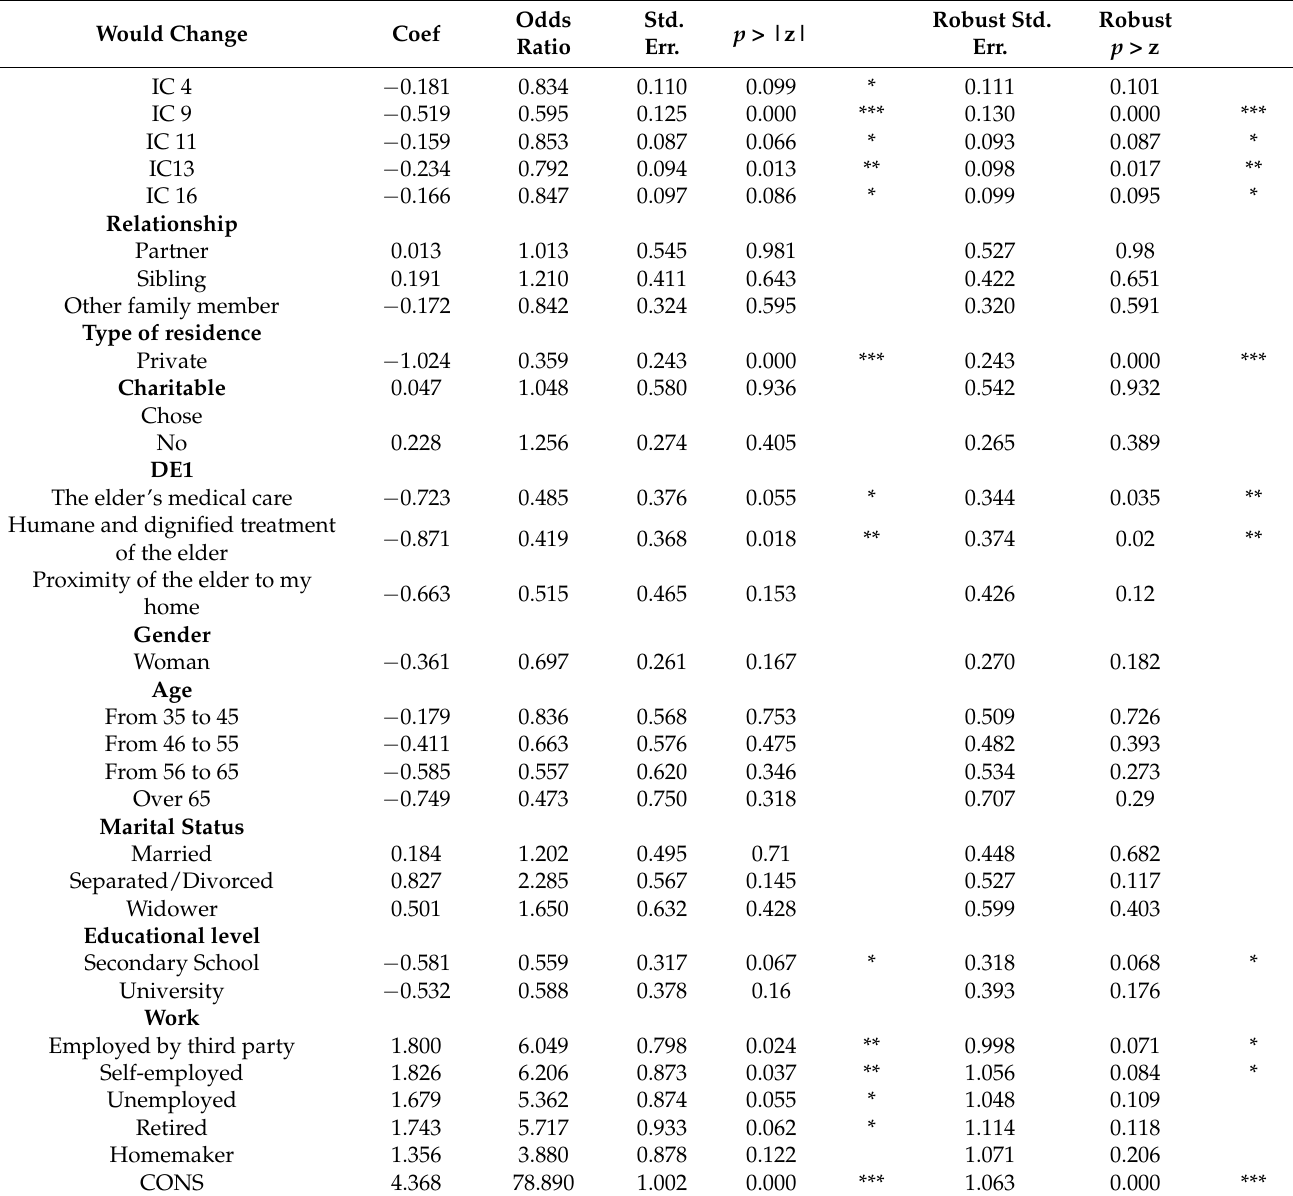
Table 5. Logit regression